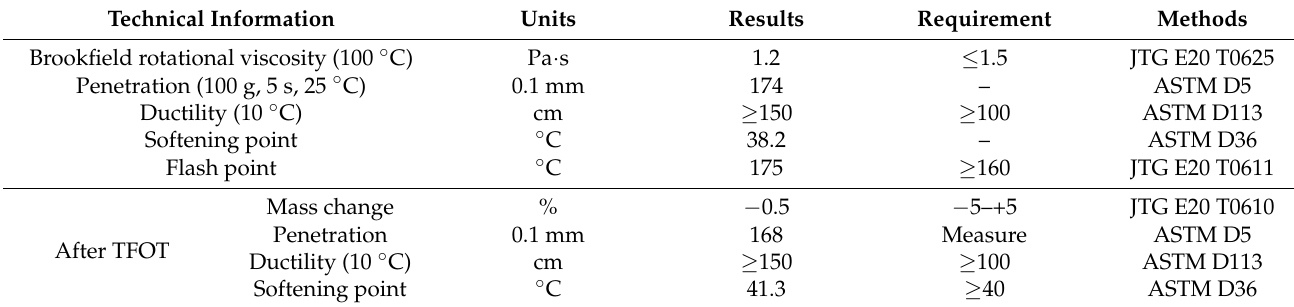
Table 2. Technical information of the LCA-modified asphalt binder.